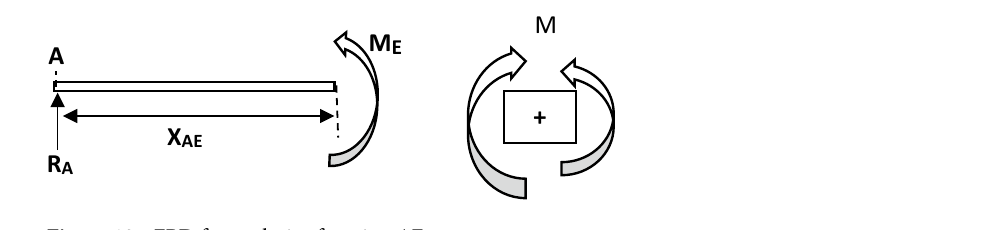
Figure 13. FBD for analysis of section AE.